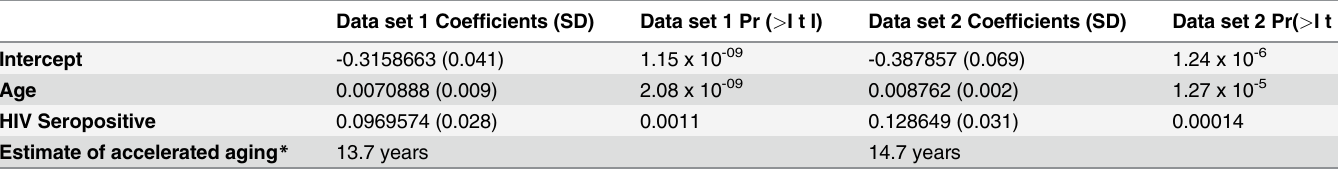
Table 2. Estimating accelerated aging due to HIV-1 infection using a multivariate